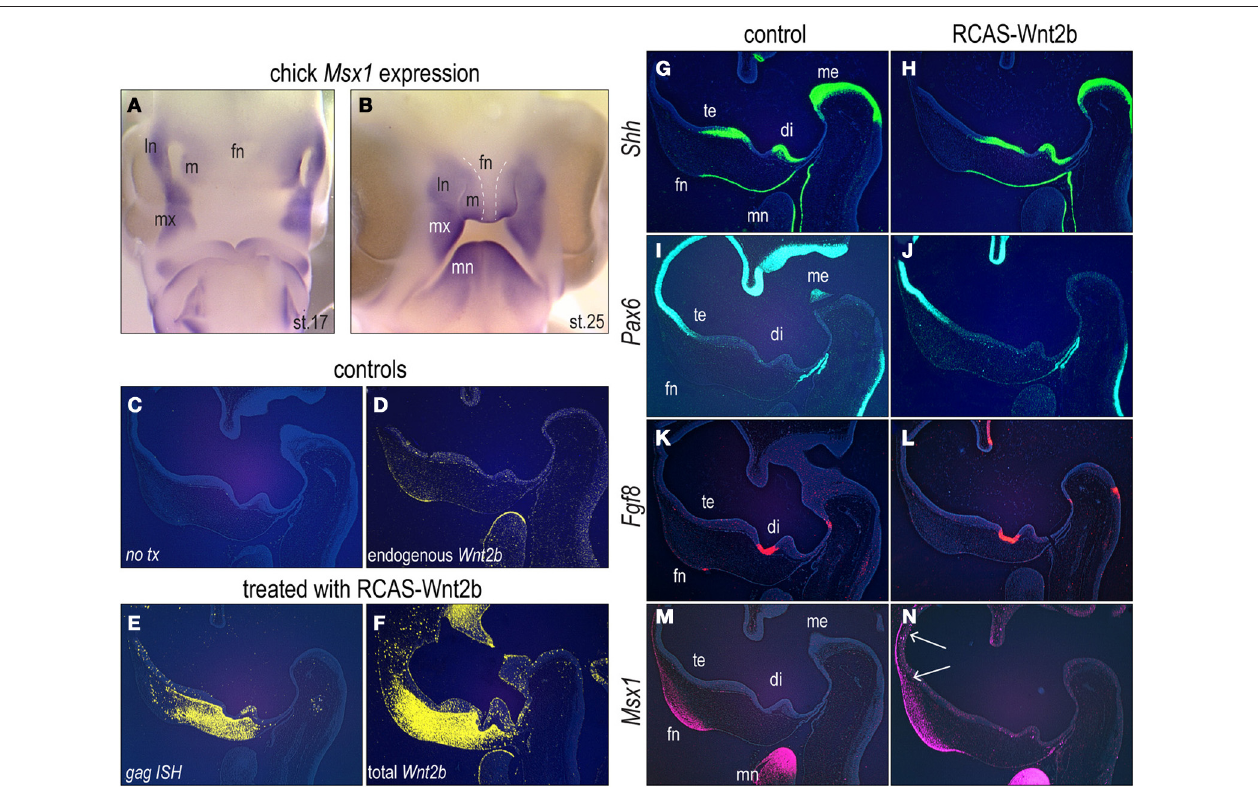
to the face. (F) RCAS:Wnt2b infection drives ectopic Wnt2b expression. Forty-eight hours after RCAS:Wnt2b treatment, chicken embryos were assessed for alterations in (G,H) , Shh , (I,J) Pax6 , (K,L) Fgf8 and (M,N) Msx1 expression.White arrows indicate expanded Msx1 expression domain. Di, diencephalon; fn, frontonasal prominence; ln, lateral nasal prominence; m, medial nasal prominence; mb, midbrain; me, metencephalon; mn, mandibular prominence; mx, maxillary prominence; np, nasal pit; te, telencephalon.